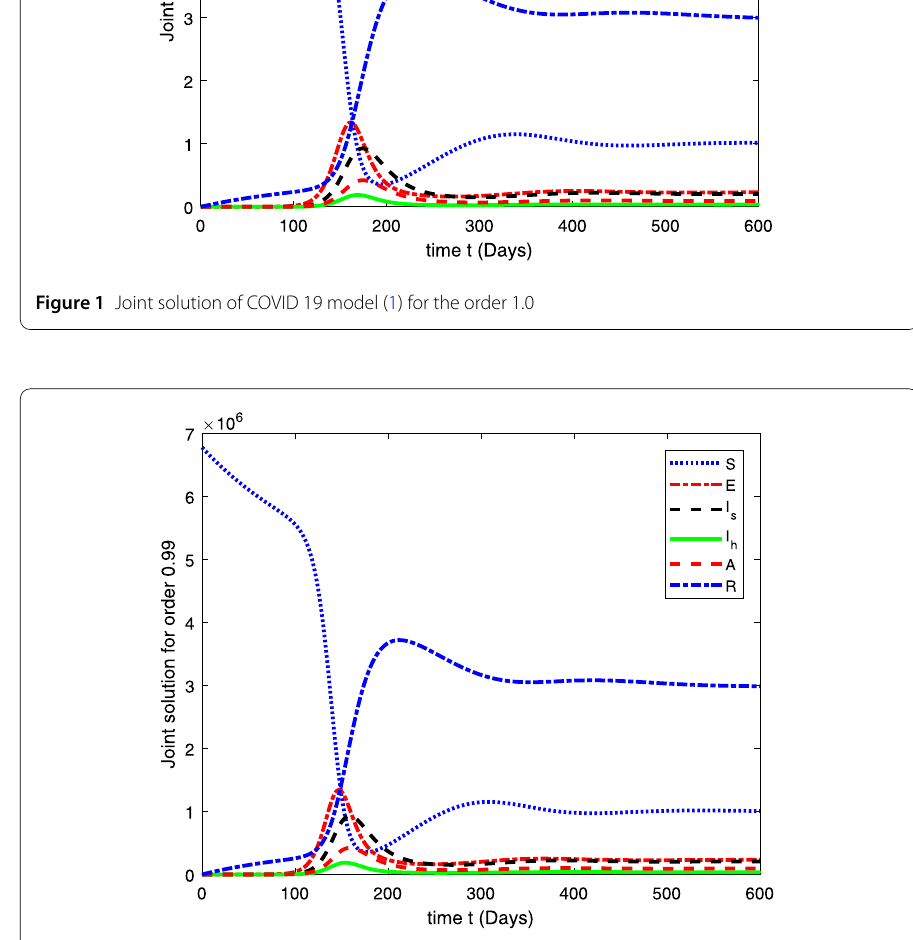
Figure 2 Joint solution of COVID 19 model (1) for the order